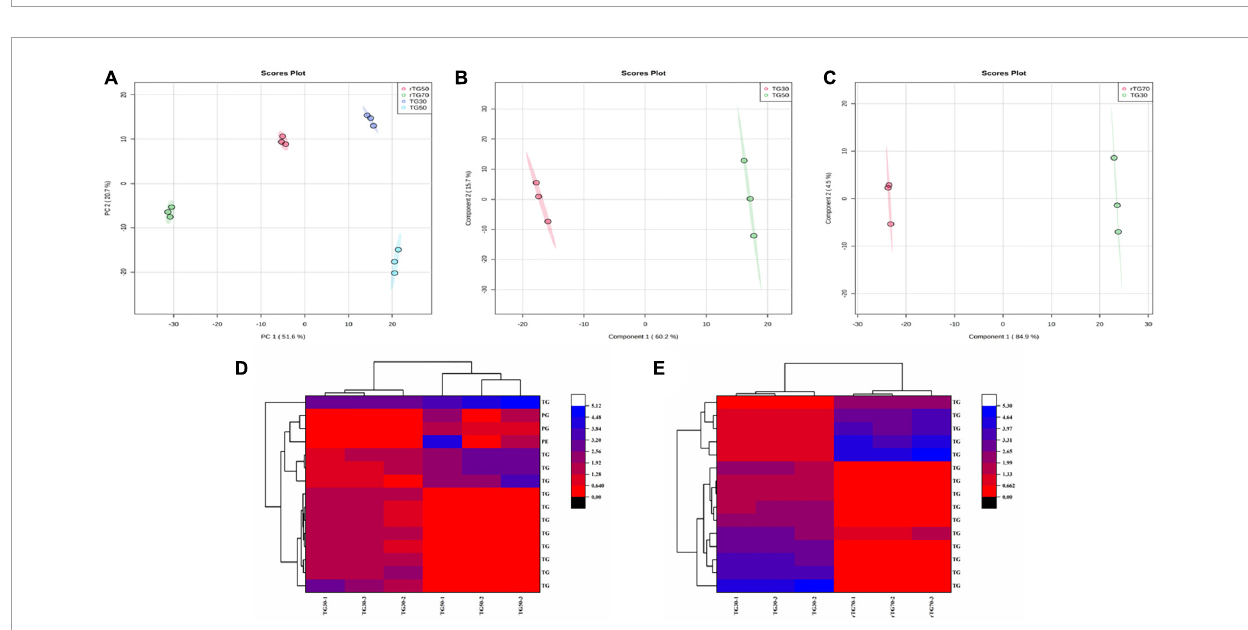
FIGURE3 The statistical analysis of EPA/DHA lipid molecules. (A) PCA score plots (TG30, TG50, rTG50, and rTG70); (B) PLS-DA score plots (TG30 and TG50); (C) PLS-DA score plots (TG30 and rTG70); (D,E) heatmaps of the lipids content which at the top fifteen with VIP values of different comparison groups (D: TG30 and TG50; E: TG30 and